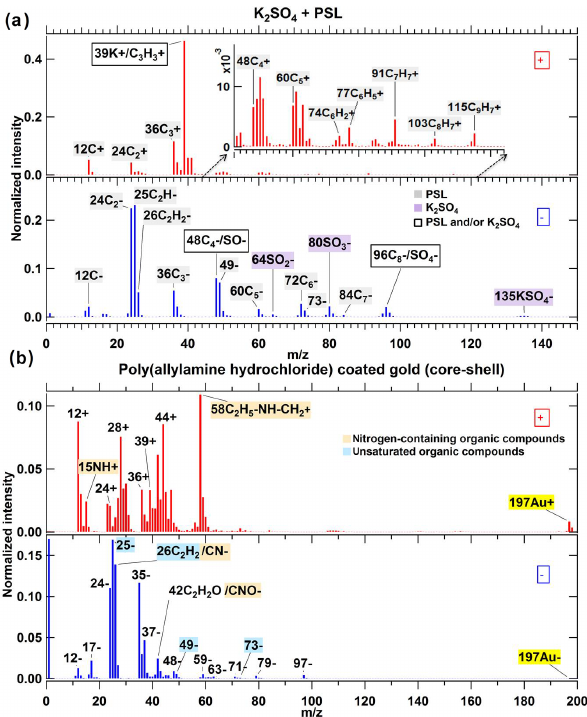
Figure 5. Average mass spectra for core–shell particles of (a) PSL coated with K 2 SO 4 , d va = 805nm, 609 single spectra averaged, and (b) poly(allylamine hydrochloride)-coated gold (Au) particles with geometric 300nm gold core and 50nm thick organic shell, 417 single spectra averaged. In (a) , grey and purple label shadings repre- sent the fragments arising from pure PSL and pure K 2 SO 4 compo- nents, respectively; box labels represent the fragments with contri- butions from core and shell compounds. In (b) orange and blue label shadings represent the fragments arising from nitrogen-containing and unsaturated organic compounds, respectively, and yellow label shadings represent